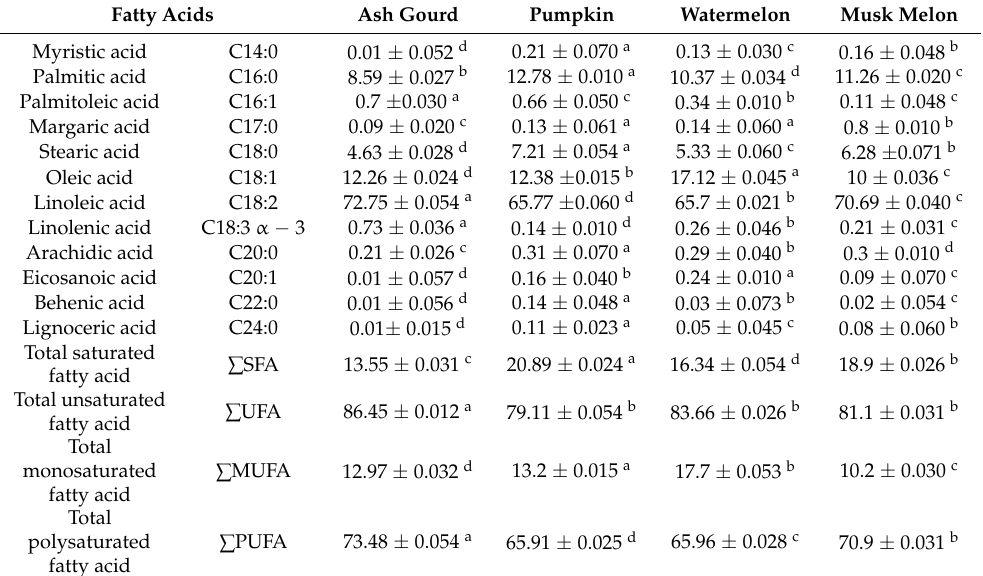
Table 3. Fatty acid composition of seeds (%).